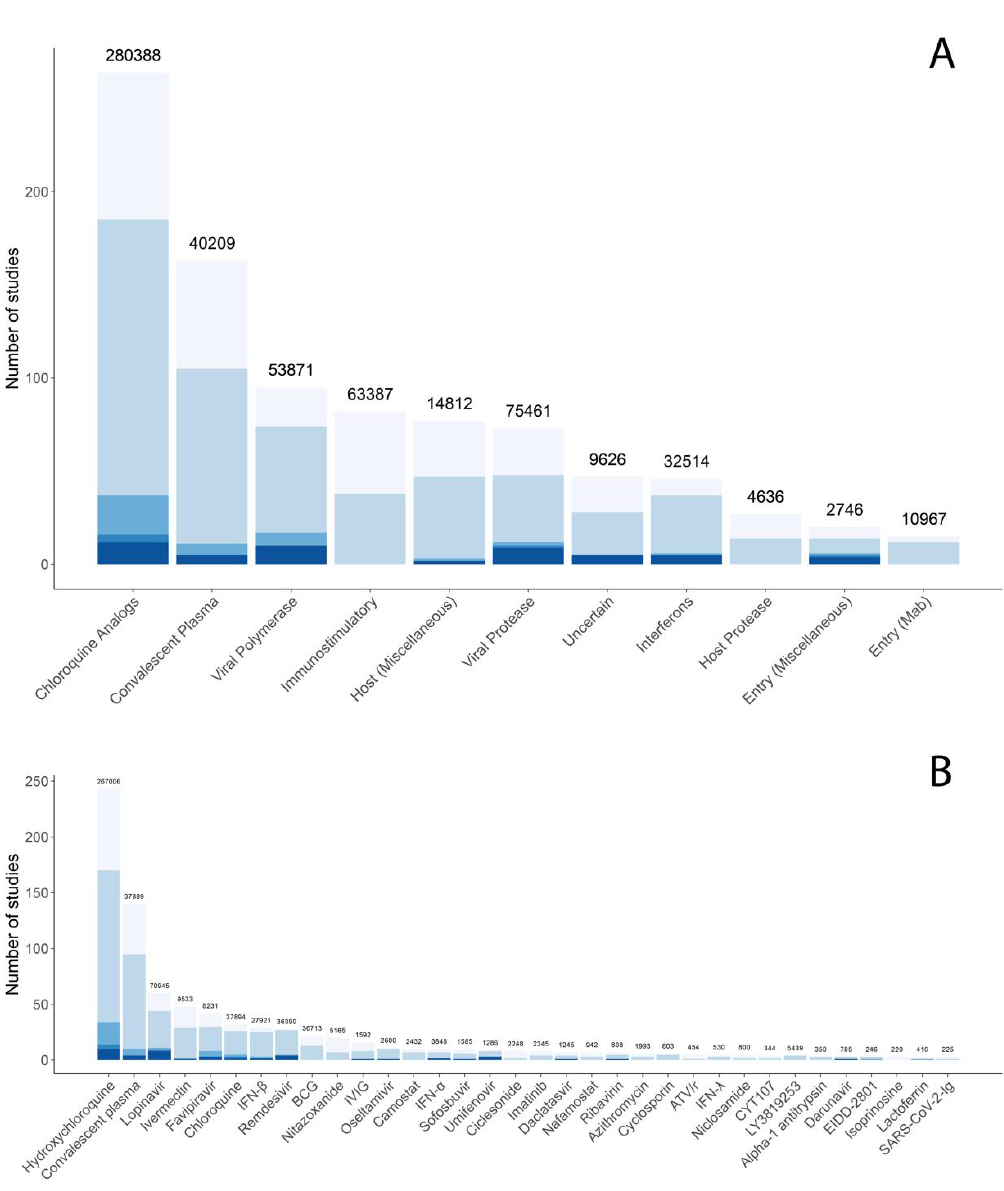
Figure 6. Distribution of targets ( A ) and the most commonly studied compounds ( B ) for published (bottom), ongoing (middle), and planned (top) antiviral clinical trials through August 6. Although chloroquine analogs are considered to act primarily through the inhibition of virus endosomal trafficking, they are separated out from other endosomal trafficking inhibitors in ( A ). ( B ) shows compounds included in three or more trials.